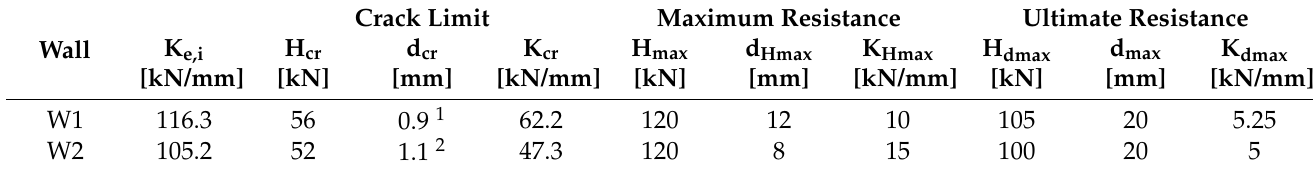
Table 2. Resistance and deformability parameters for plain walls W1 and W2.